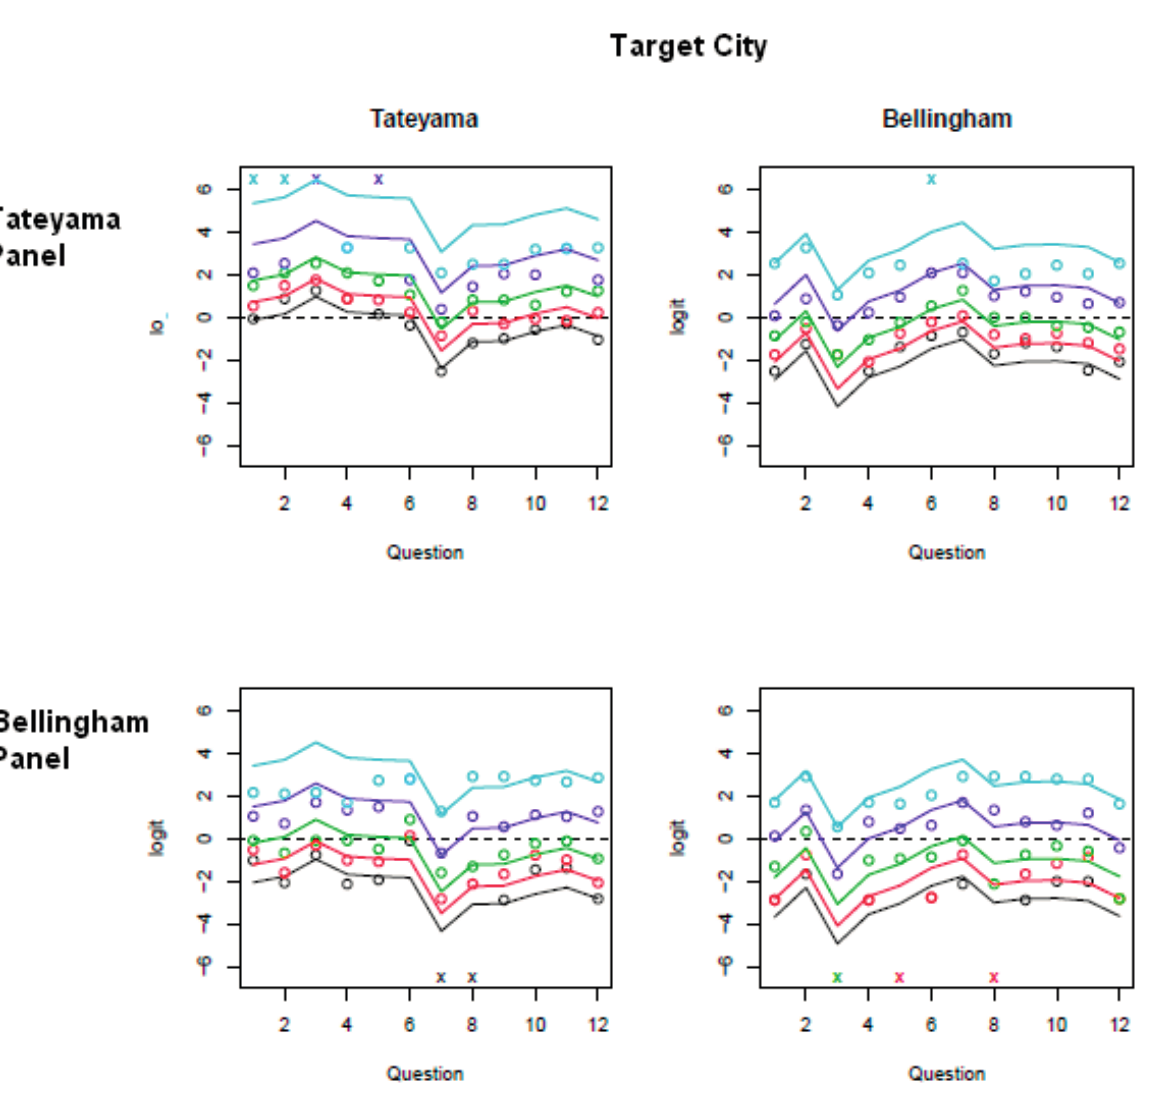
Figure 1. QOL Model fit to Sister-city QOL indicators. The top (bottom) row of plots give the fitted values when the respondent was from Tateyama (Bellingham). The left hand (right hand) column gives plots when the questions were asked about Tateyama